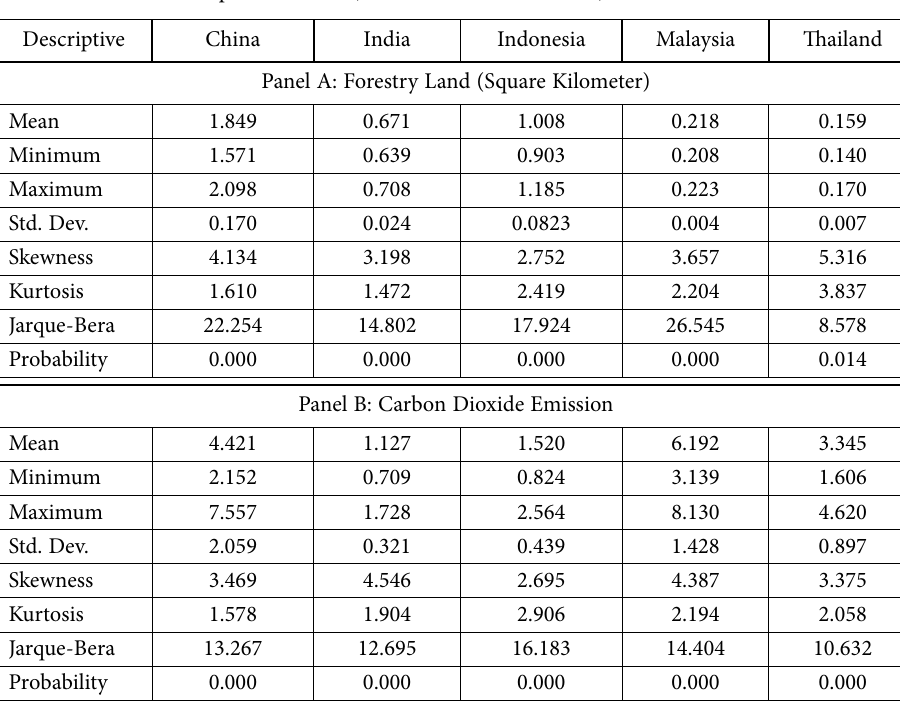
Table 1. Results of descriptive statistics (source: authors estimation)